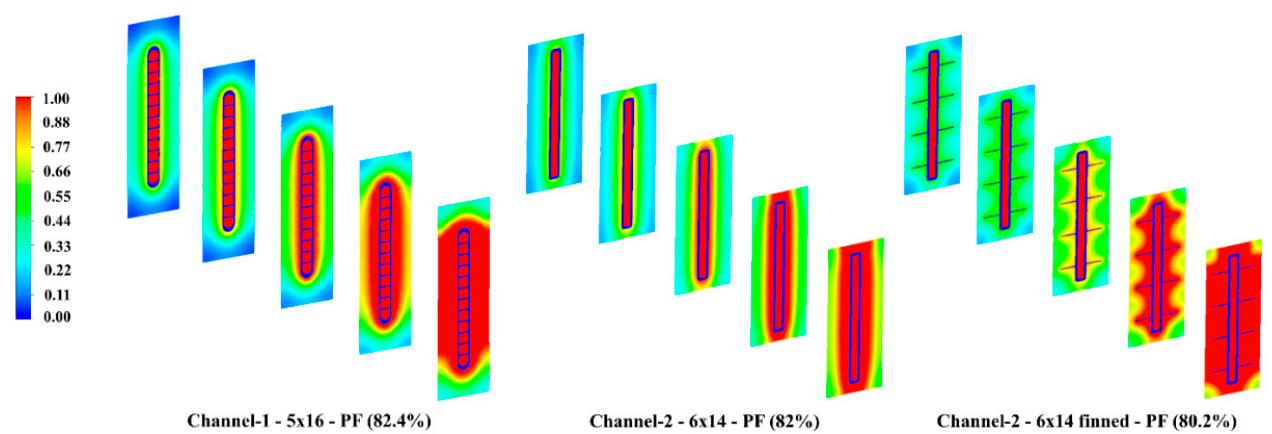
Figure 6. Melt fraction contours within melting for the configurations of channel-1 (PF = 82.4%), channel-2 (PF = 82%) and channel-2-finned (PF = 80.2%).